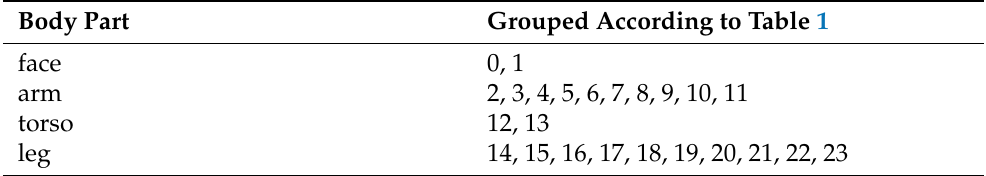
Table 2. Grouping rules for BodyPix model key parts. Body Part Grouped According to Table